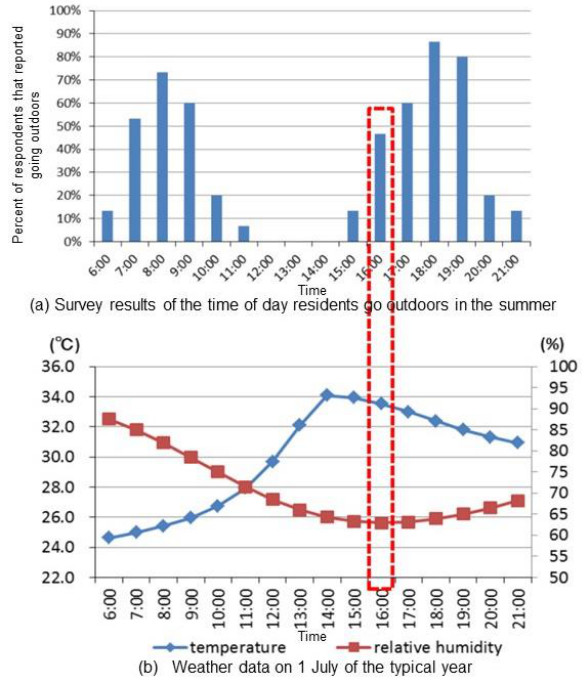
Figure 2. The survey results of the time of day residents go outdoors in the summer ( a ) and the weather data on the 1 July of a typical year (b).